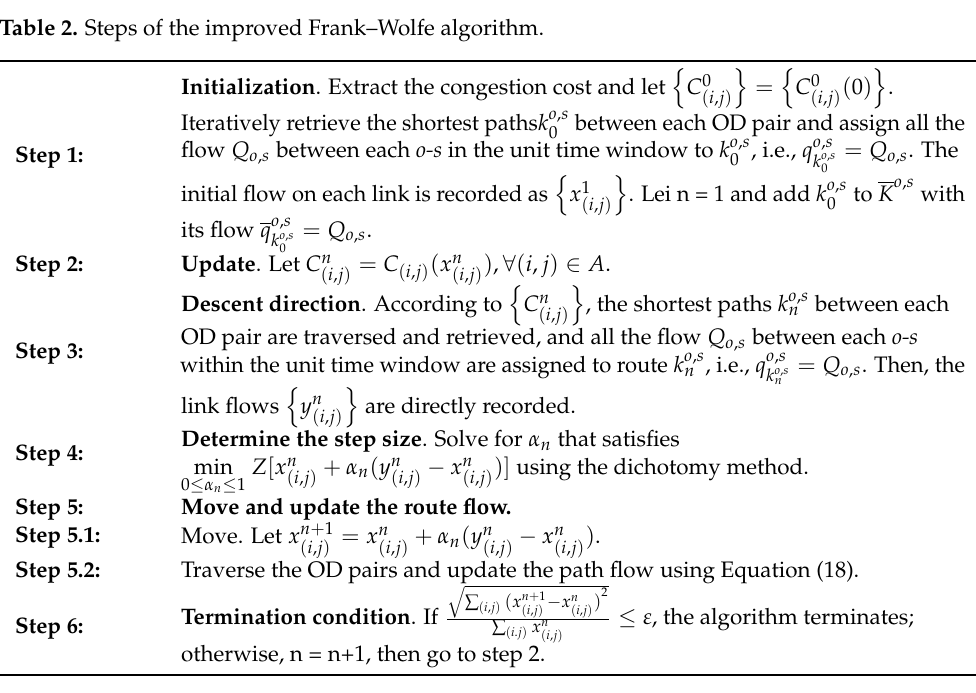
algorithm are in Table 2, which return the optimal traffic flow distribution on the candidate K shortest paths.